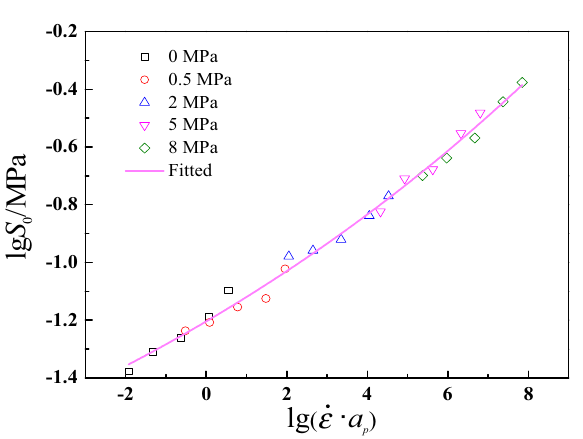
Figure 12. Master curve of damage initiation parameter S 0 for CSP.